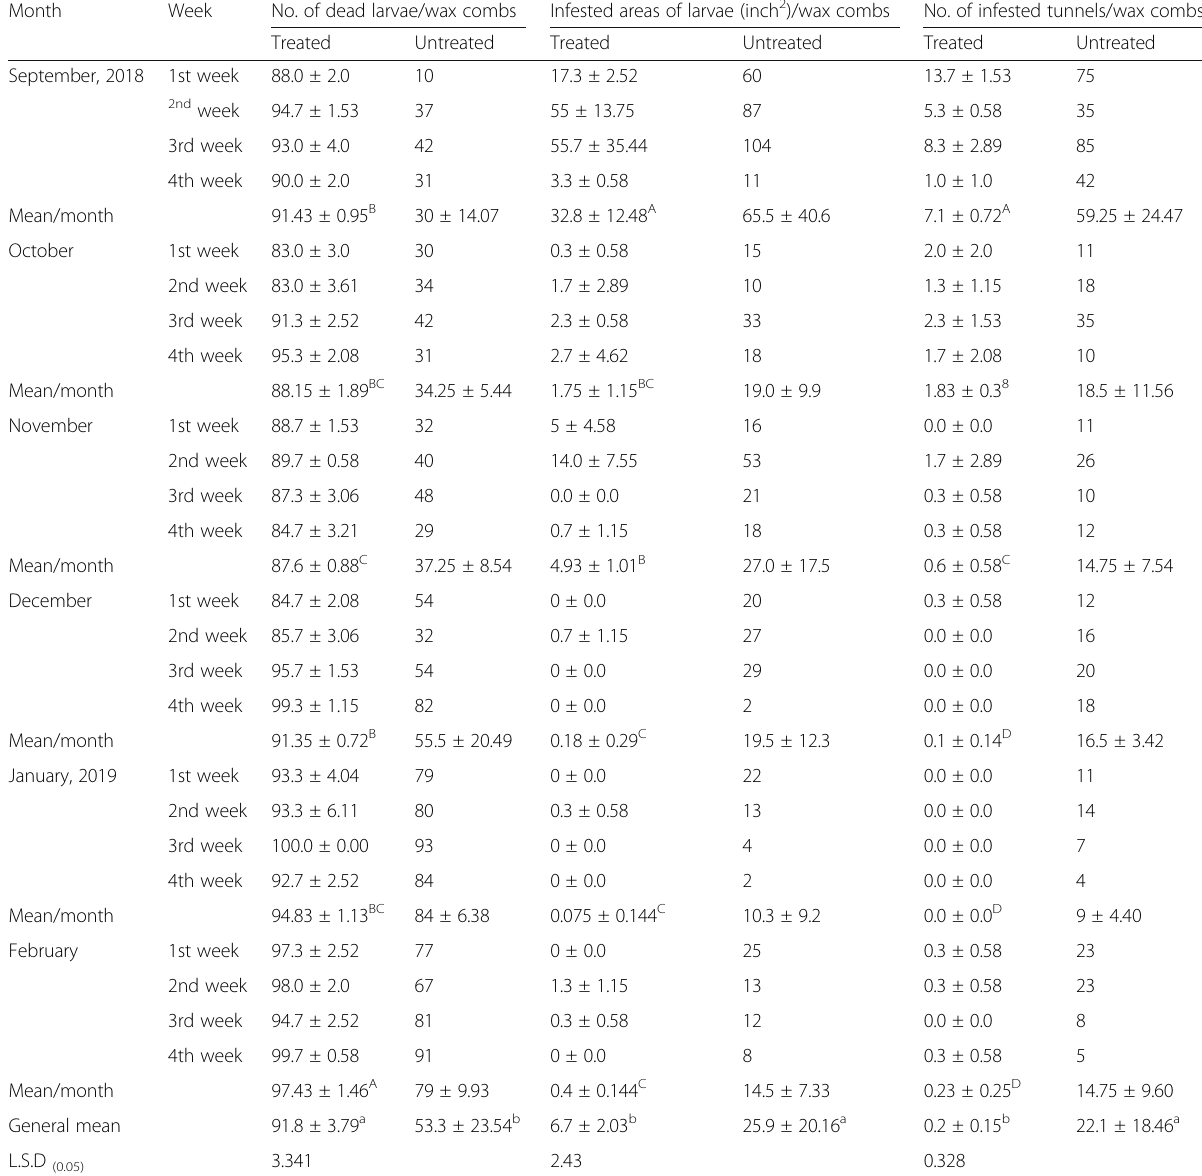
Table 1 Mean numbers of dead larvae, infested areas, and numbers of infested tunnels/colony caused by the greater wax moth, G. mellonella in treated and untreated honeybee colonies Month Week No. of dead larvae/wax combs Infested areas of larvae (inch 2 )/wax combs No. of infested tunnels/wax